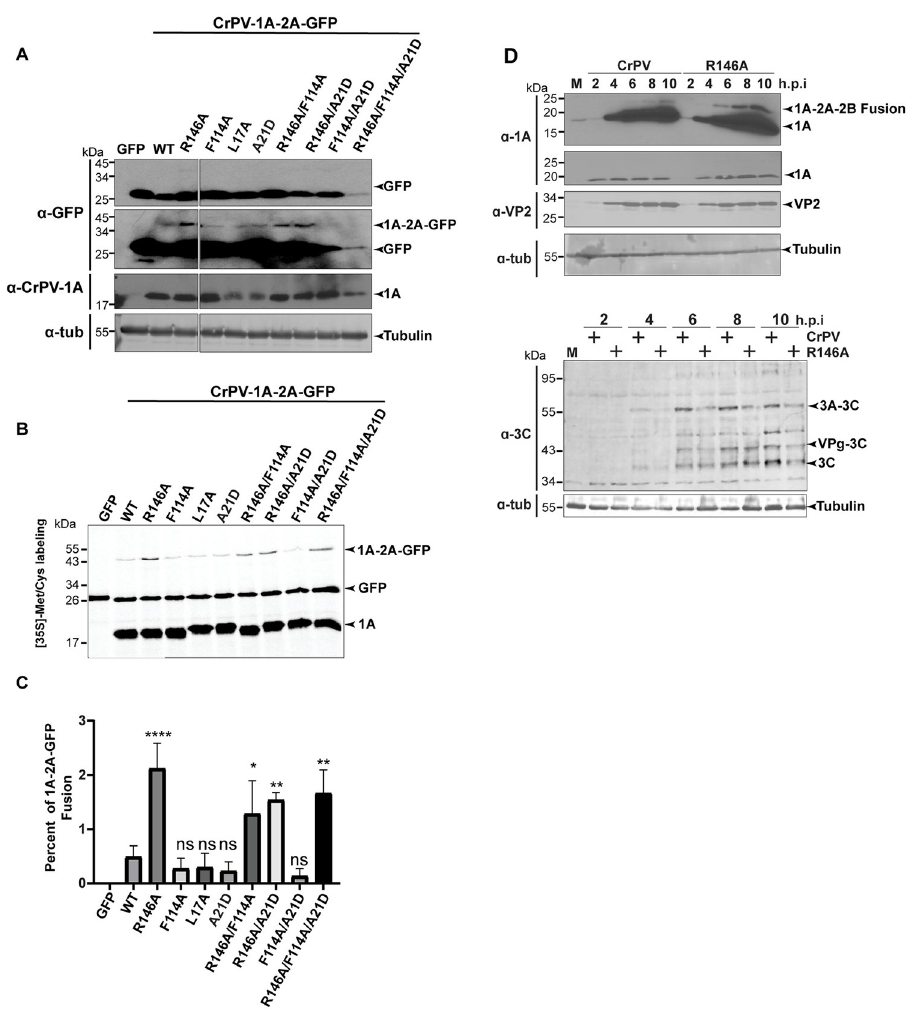
Fig 3. R146 of CrPV-1A promotes full 2A peptide activity: (A) Immunoblots of lysates from S2 cells transfected with the indicated reporter RNAs (16 hours post transfection). A light exposure (top) and longer exposure (bottom) of an anti-GFP immunoblot and CrPV-1A immunoblot is shown. (B) Autoradiography of [ 35 S] Met/Cys labelled proteins from in vitro sf-21 translation reactions incubated with the indicated RNAs. (C) Percent quantification of [ 35 S] Met/ Cys labelled CrPV-1A proteins. Data are mean ± SD from three independent experiments. p > 0.05 (ns), p < 0.002 ( �� ), p < 0.0001( ���� ) by a one-way ANOVA (nonparametric) with a Bonferroni’s post hoc-test. (D) Immunoblots of lysates from S2 cells infected with (M) mock, CrPV or CrPV (R146A) (MOI 10) at indicated time points.